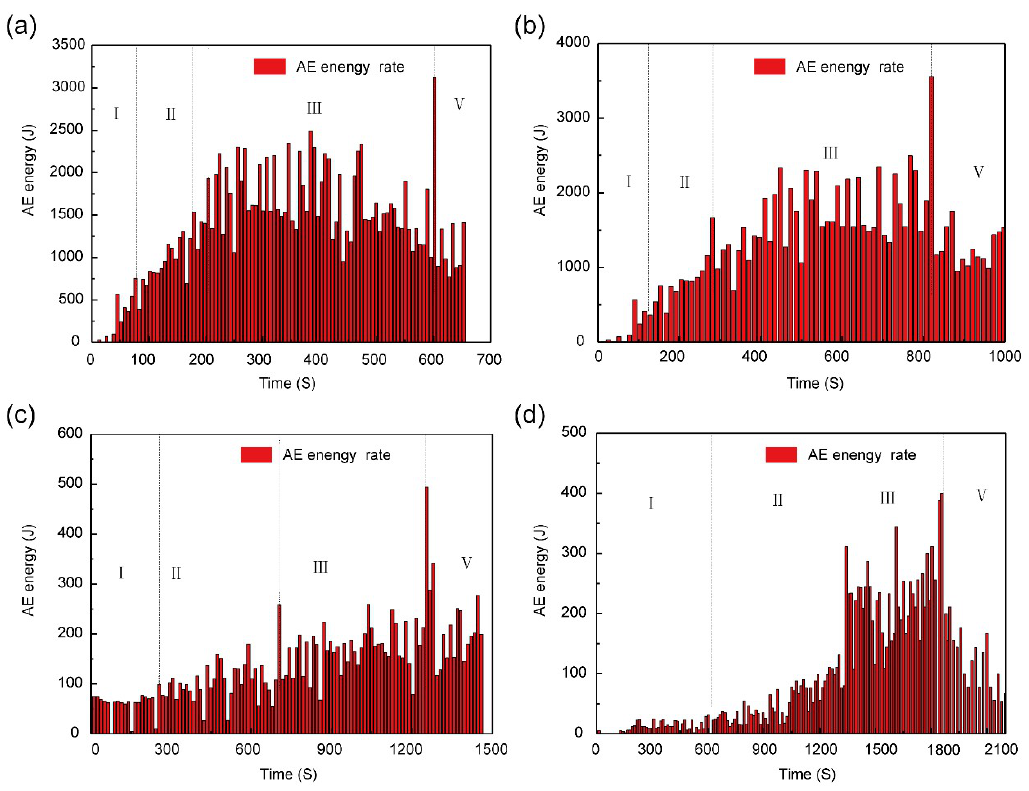
Figure 8. Histogram of AE energy of rock salt under triaxial compression test: ( a ) confining pressure of 5 MPa; ( b ) confining pressure of 10 MPa; ( c ) confining pressure of 15 MPa; and, ( d ) confining pressure of 20 MPa.